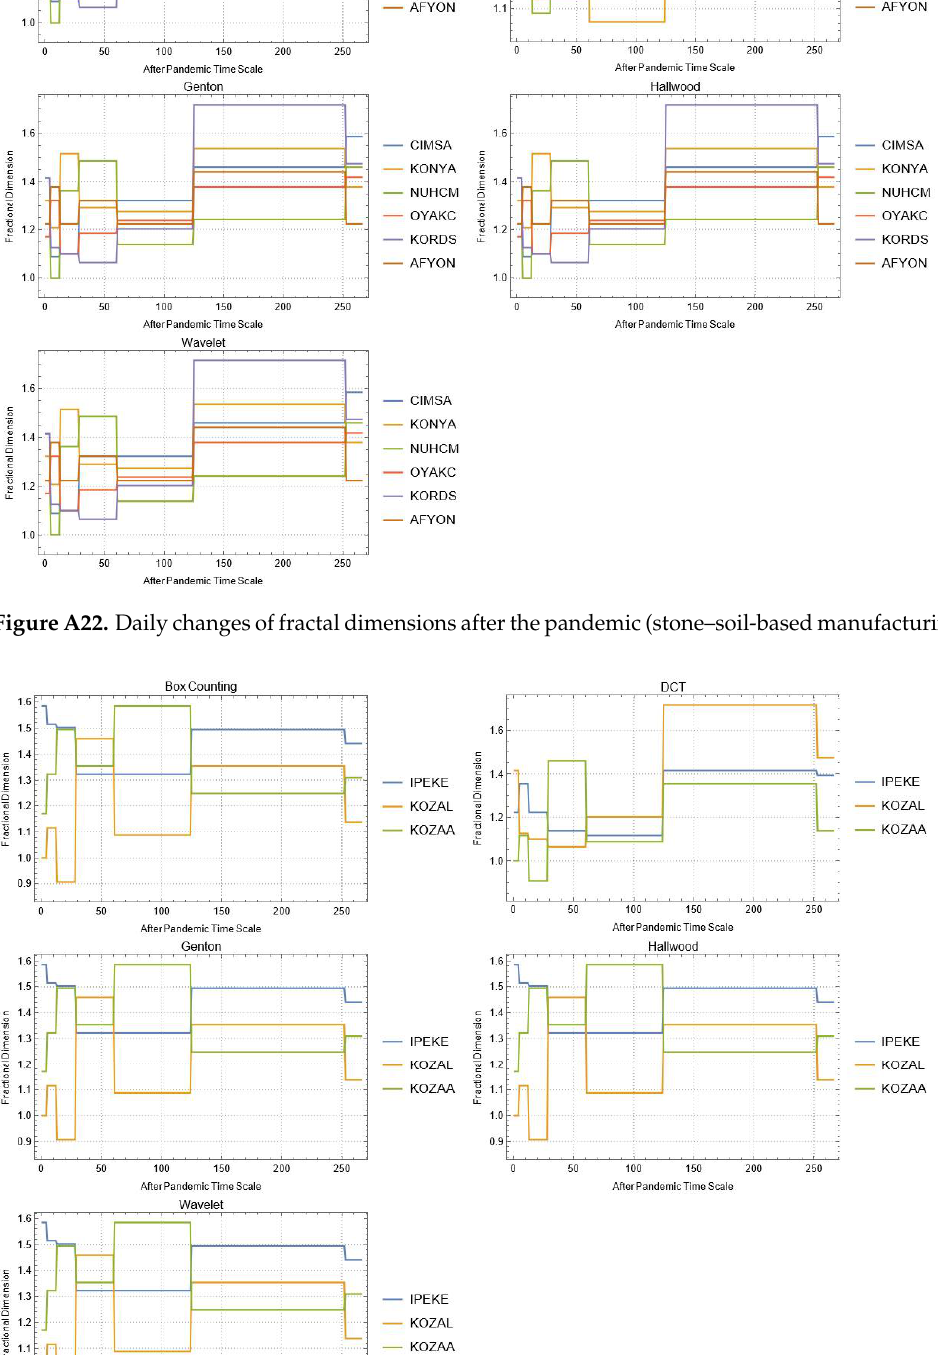
Figure A23. Daily changes of fractal dimensions after the pandemic (mining).